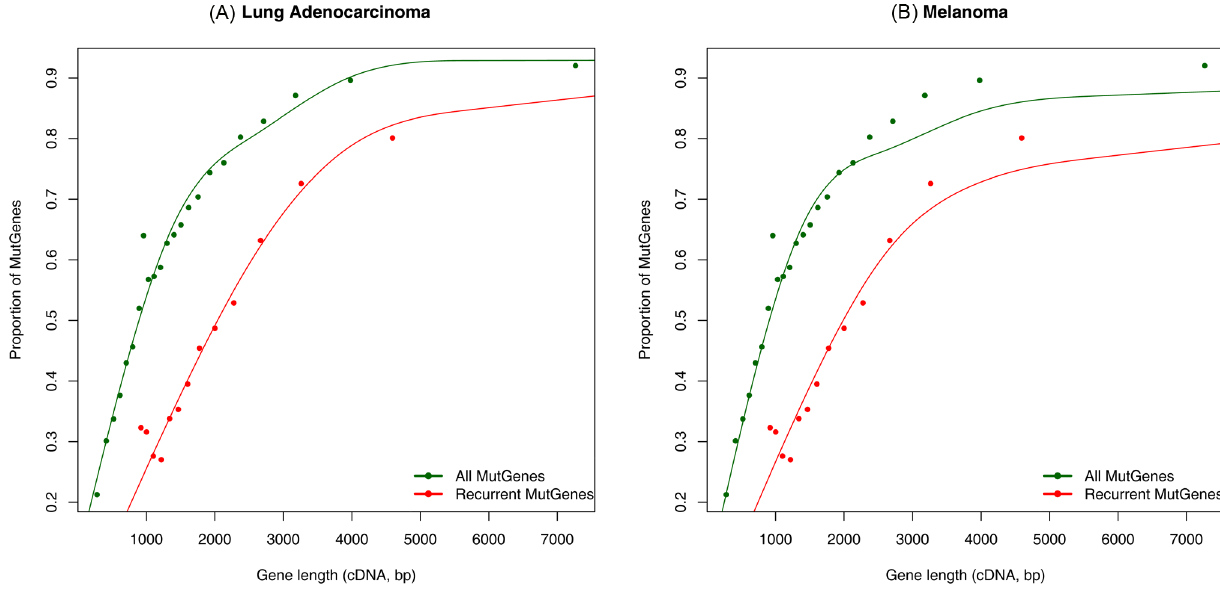
Figure 2. Distribution of mutation genes (MutGenes) as a function of gene length (cDNA length). (A) The proportion of MutGenes in lung adenocarcinoma (LUAD) samples versus gene length (cDNA length). The green line indicates all MutGenes in the 182 LUAD samples, and the red line indicates recurrent MutGenes, which occurred in $ 2 LUAD samples. (B) The proportion of MutGenes in melanoma samples versus gene length (cDNA length). The green line indicates all MutGenes in the 121 melanoma samples, and the red line indicates recurrent MutGenes, which occurred